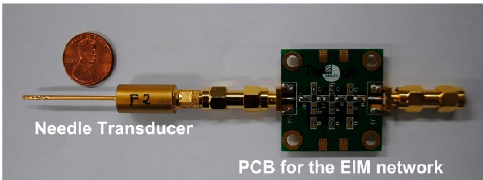
Figure 15. Needle ultrasonic transducer with filter based electric impedance matching network. Reproduced with permission from Reference [120], Copyright Elsevier, 2016.